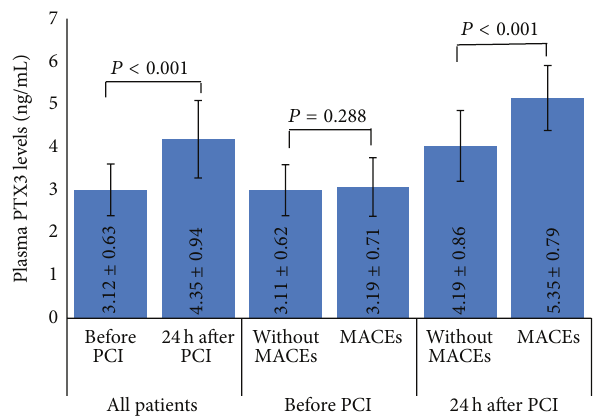
Figure 1: Plasma PTX3 levels in patients: 24 h after PCI versus before PCI in all patients, MACEs group versus without MACEs group before PCI, and MACEs group versus without MACEs group at 24 h after